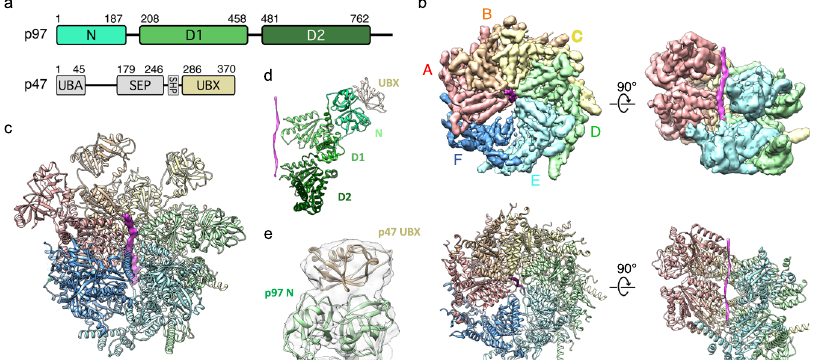
Fig. 1 Structure of substrate-bound p97 – p47 complex. a Domain organization of p97 and p47. Domains are labeled and residue ranges indicated. b Top and side views of high-threshold segmented map and re fi ned model (subunits A-F of p97 labeled). The substrate peptide density and model are colored magenta. c Model of the complete p97 complex including N domains modeled in the ‘ up ’ conformation. d Model of a p97 protomer (subunit D shown) with the associated p47 UBX domain. Orientation corresponds to the side view on panel ( b ). e Low threshold density fi tted with a p97 N domain and p47 UBX domain.